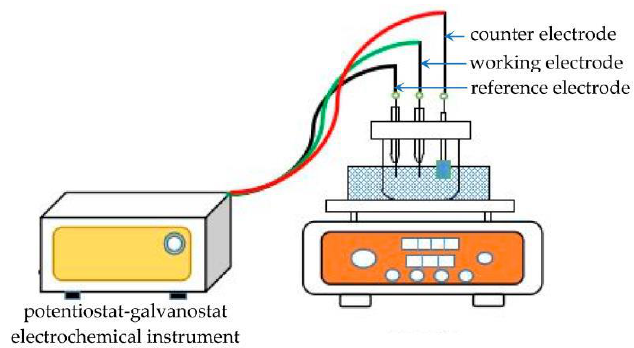
Figure 2. Schematic representation of the electrochemistry and electrodeposition experiment apparatus. Reproduced from [30] with permission from MDPI, 2023.